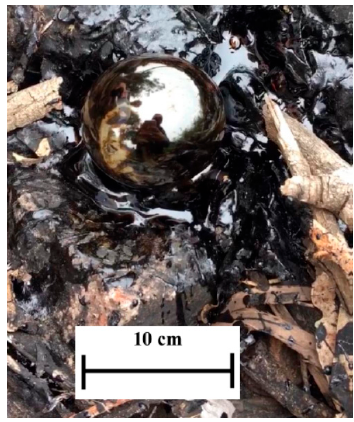
Figure 1. Example of macroseepage, as the asphalt bubble forming shows gas escape. Picture taken at the Carpinteria sample site.